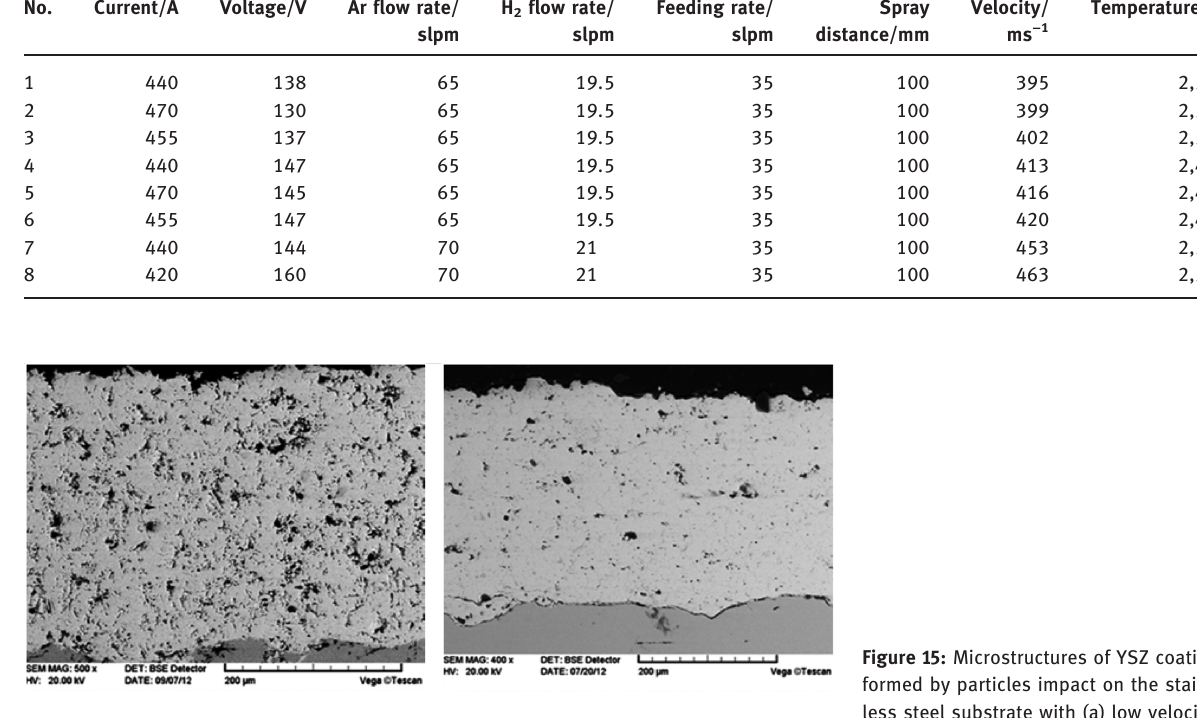
Figure 15: Microstructures of YSZ coatings formed by particles impact on the stain- less steel substrate with (a) low velocity, (b) high velocity.